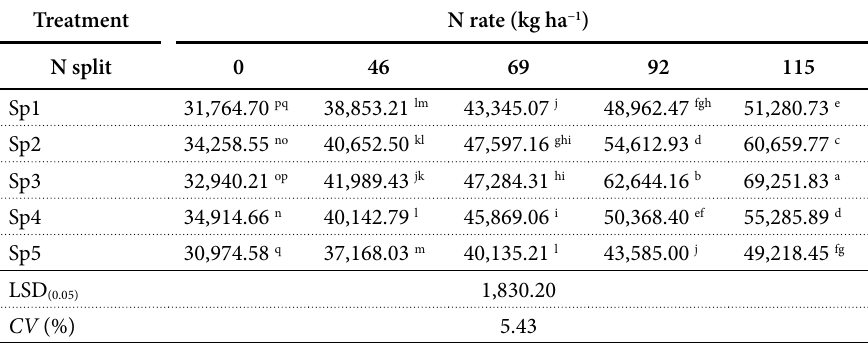
of Curcuma longa grown at Tepi, southwestern Ethiopia in 2016/2017.